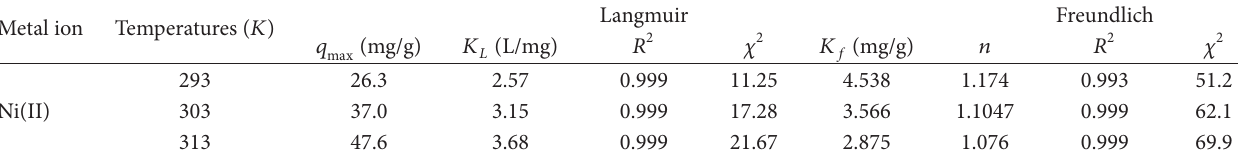
T 2: Langmuir and Freundlich isotherm parameters for the biosorption of Ni(II) on T.viride biomass at different temperatures. Metal ion